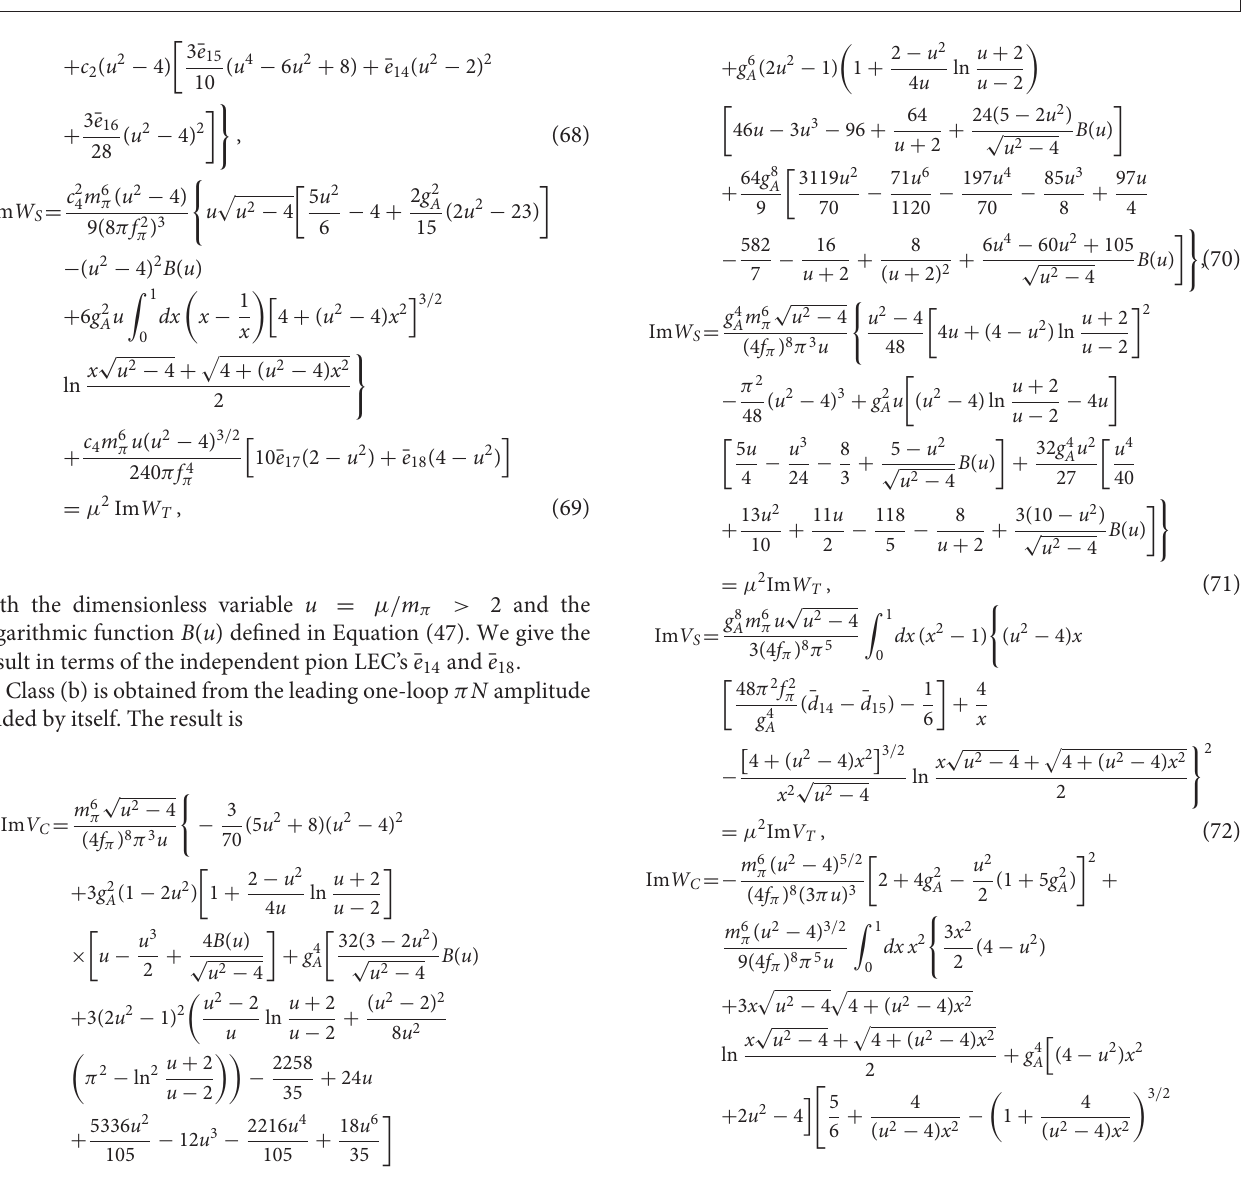
FIGURE 5 | N 4 LO 3 π -exchange contributions to the NN interaction. The classification scheme of Kaiser [47] is applied. The same notation as in Figure 2 is use. Reprinted figure with permission from Entem et al. [46], copyright (2015) by the American Physical